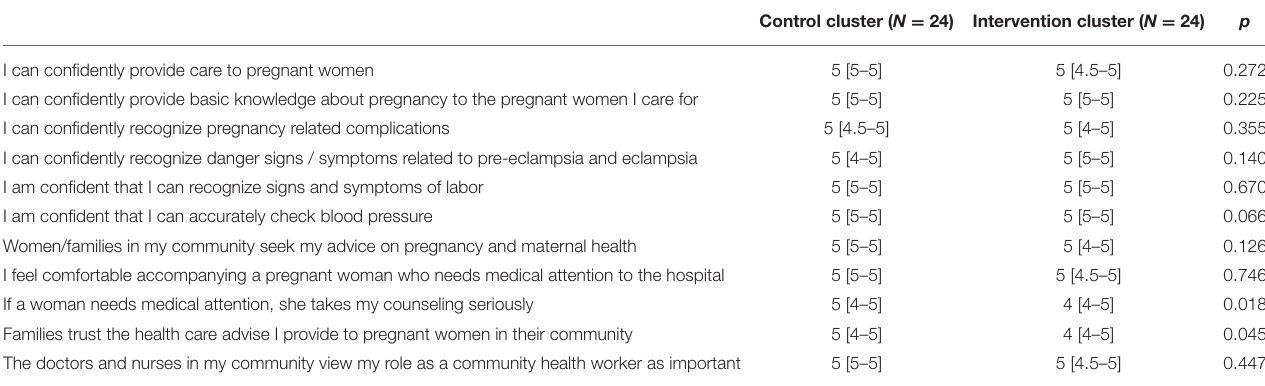
TABLE 2 | Knowledge and self-efficacy responses.